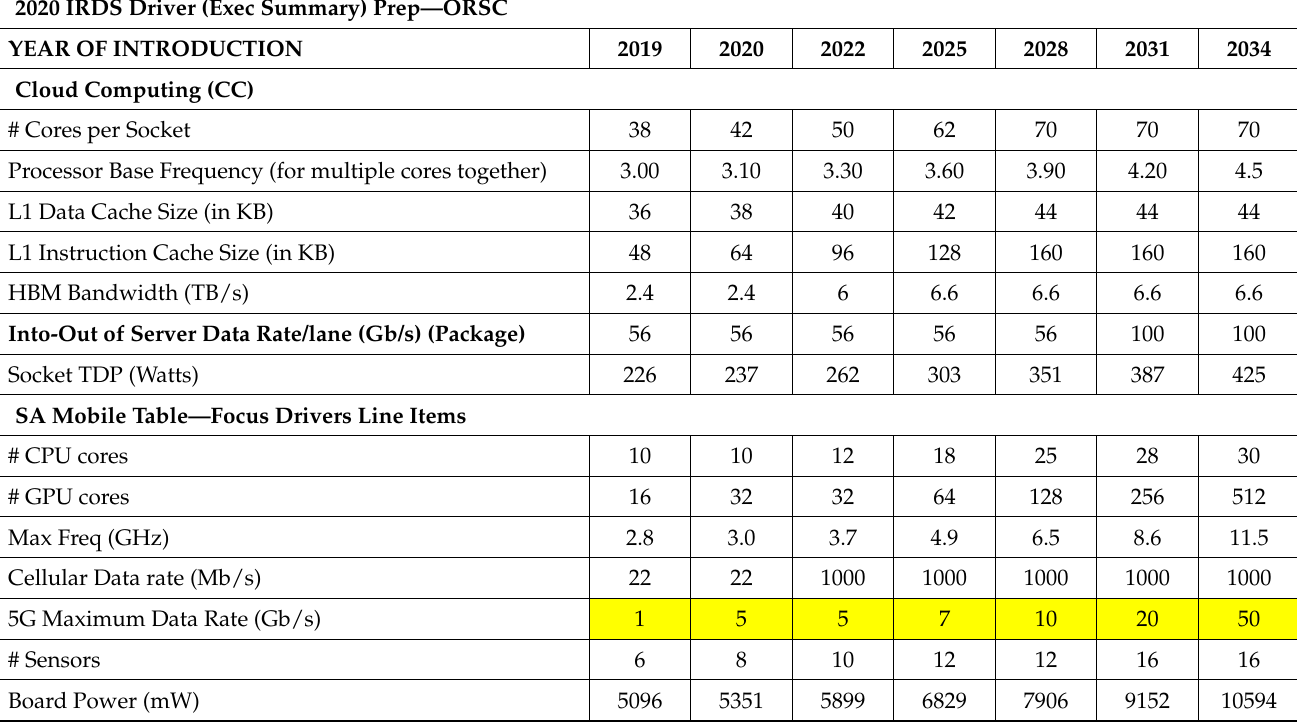
Table 1. Overall Roadmap System Characteristics for the different applications (in yellow: 5G maximum data